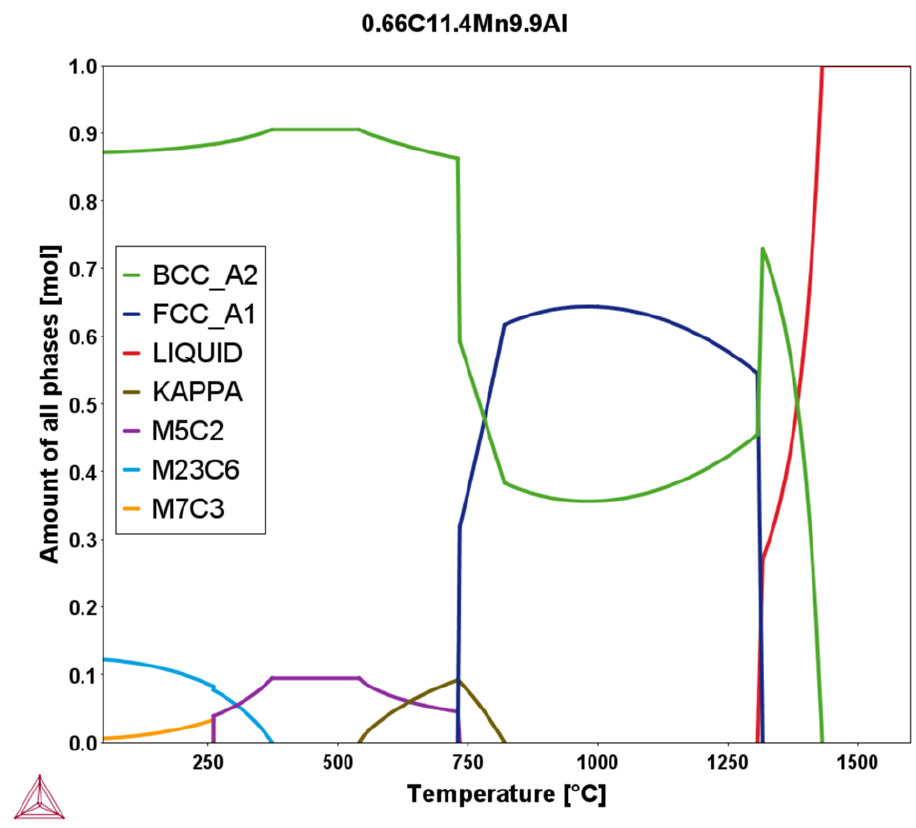
Figure 2. Phase diagram of the analyzed composition calculated with ThermoCalc®software (version 2020a, TCFe6